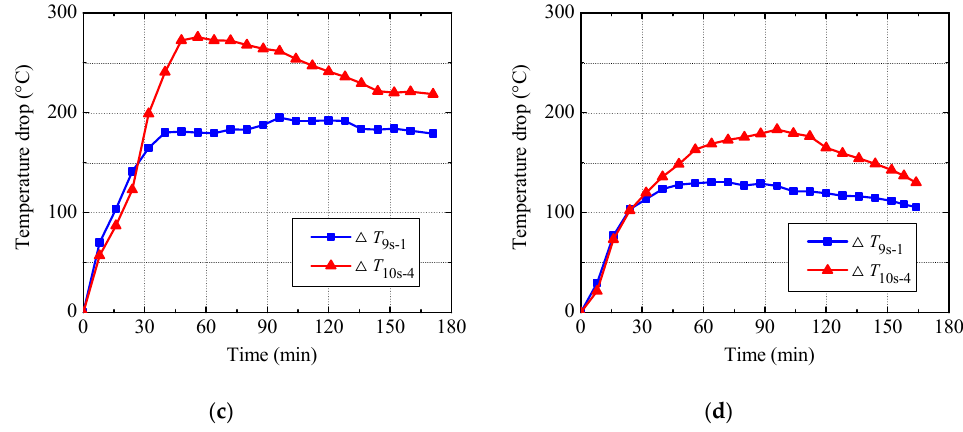
Figure 18. Temperature drop-time curves: ( a ) Specimen B1, ( b ) Specimen B3, ( c ) Specimen B4, and ( d ) Specimen B5.